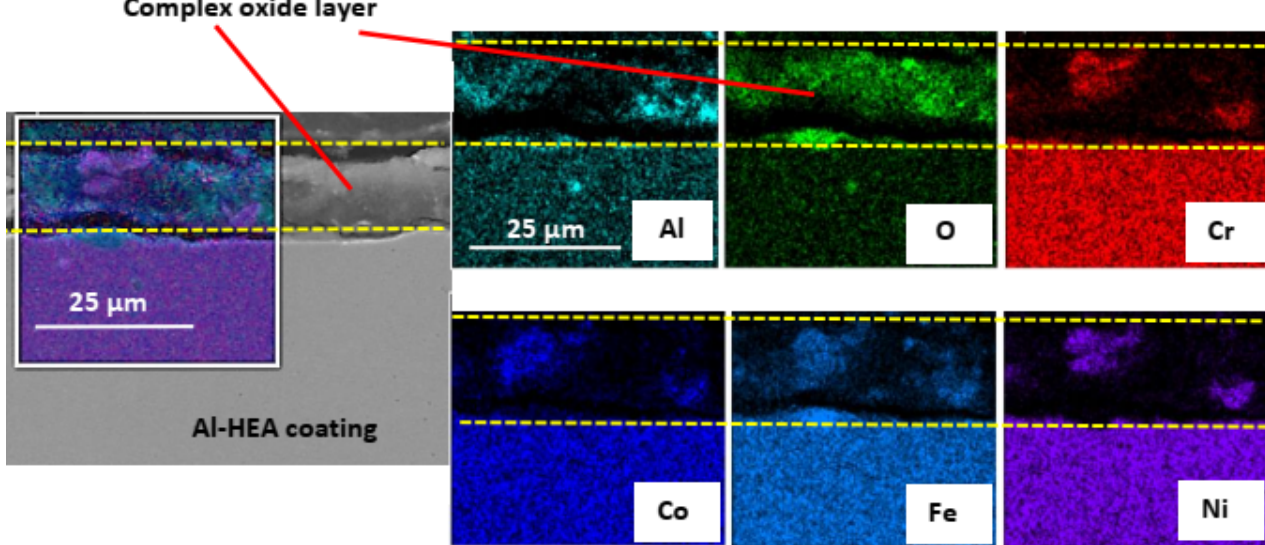
Figure 10. In some cases, the complex oxide coatings formed on the Al-HEA coating surface was continuous after the exposure to the aerated fluid.